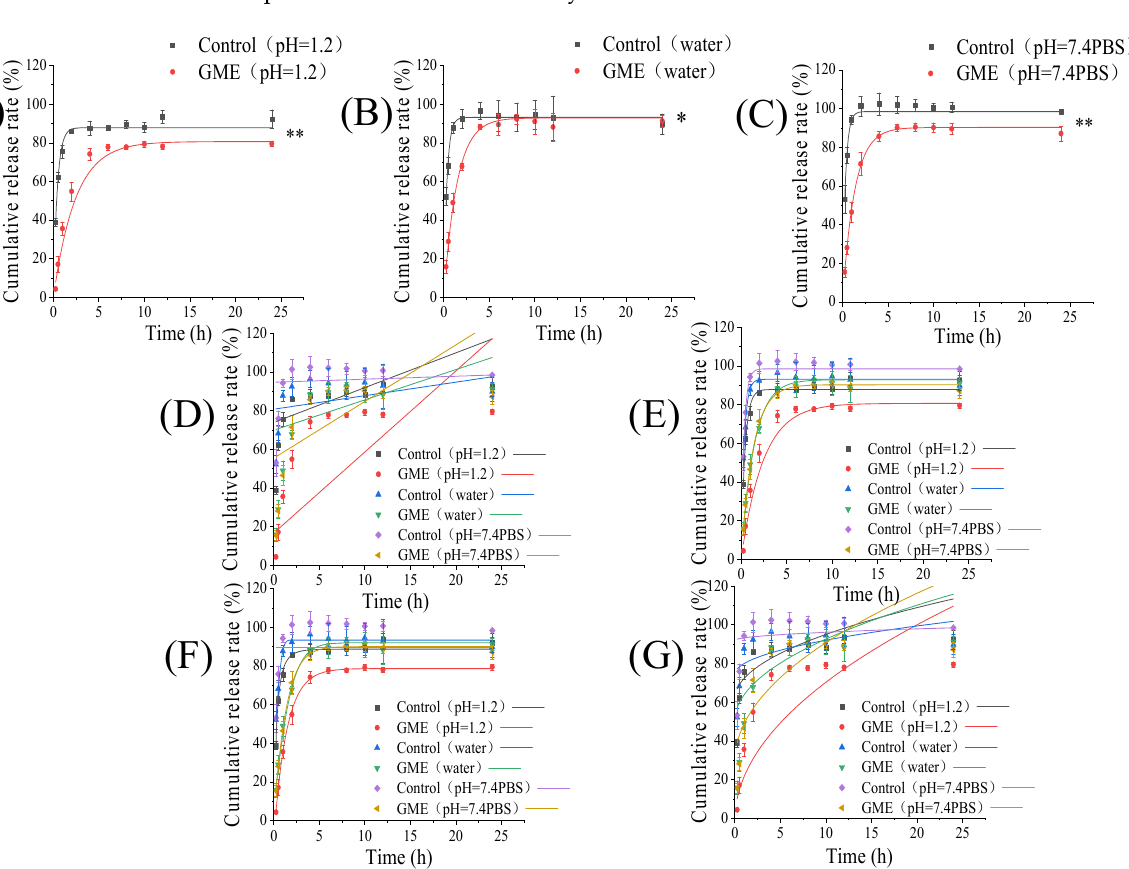
Figure 4. In vitro release of genipin in different dialysis media and the models’ fitting curves. pH = 1.2 aqueous hydrochloric acid ( A ), water ( B ), pH = 7.4PBS ( C ), zero-order model ( D ), first-order model ( E ), Higuchi model ( F ), and Weibull model ( G ); * p < 0.05, ** p < 0.01. Table 3. The equations and correlation coefficients (R 2 ) of different release models.